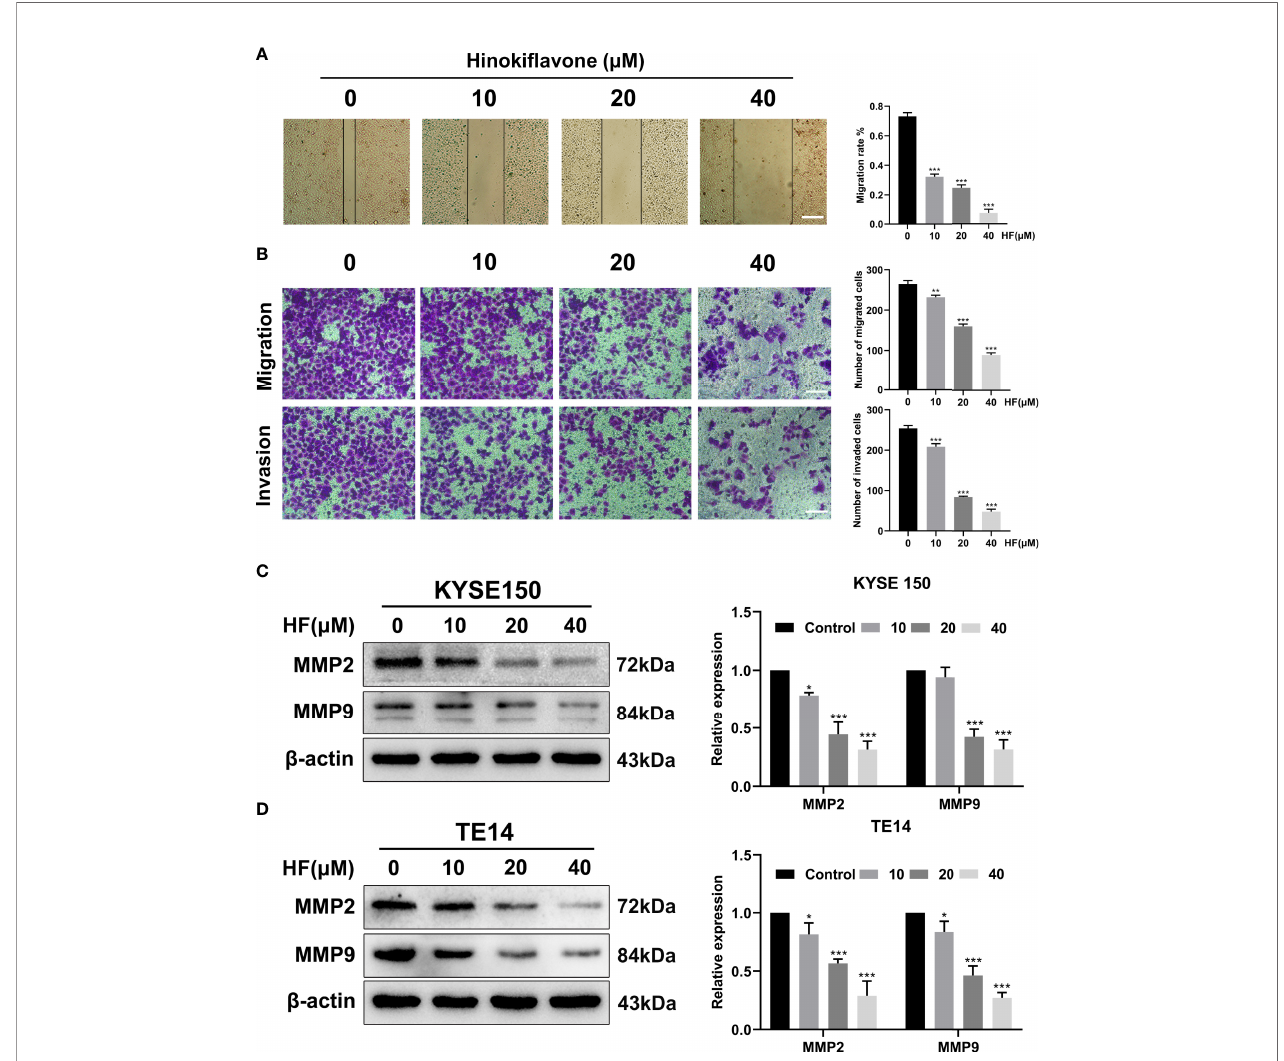
FIGURE 6 | HF inhibits ESCC cell migration and invasion. (A) Cell migration was measured in a scratch-wound assay. KYSE150 cells were cultured until reaching approximately 80-90% cell density, the culture was scratched as described in Methods, and further cultured with various concentrations of HF (0, 10, 20, and 40 m M) for 24 h, after which the cells were fi xed and photographed. Magni fi cation, ×100; scale bars = 100 µm. The distance of cell migration from the same region was quanti fi ed using ImageJ. (B) KYSE150 cells were placed in the top chamber on the Transwell membrane with serum-free medium and the upper surface of the Transwell membrane was coated with/without Matrigel. Cells were treated using HF with a concentration gradient for 24 h, and then the cells were fi xed and photographed using a microscope after crystal violet staining. Magni fi cation, ×100; scale bars = 100 µm. Migrated and invaded cells were counted as described in the Methods. (C) , (D) KYSE150 cells and TE14 cells were treated with various concentrations of HF for 24 h, and then the cells were collected for protein extraction. The extracted proteins were later used for western blot analysis to determine the protein expression levels of MMP2 and MMP9. All the above experimental data are presented as the mean ± SD of three independent experiments. *P < 0.05; **P < 0.01; ***P < 0.001 compared to 0 m M vehicle